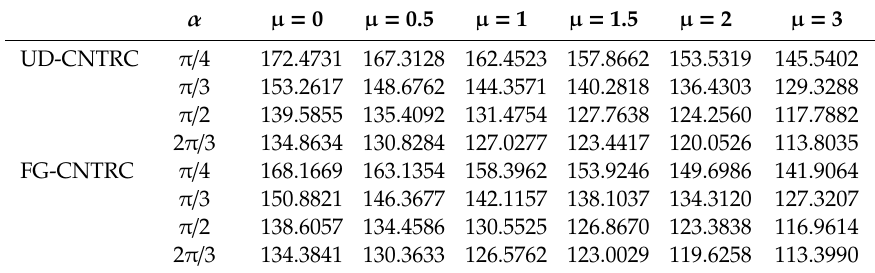
Table 10. E ff ect of the opening angle α on the nondimensional critical buckling load for C-S CNTRC = curved beams with L / h = 10, V ∗ CNT